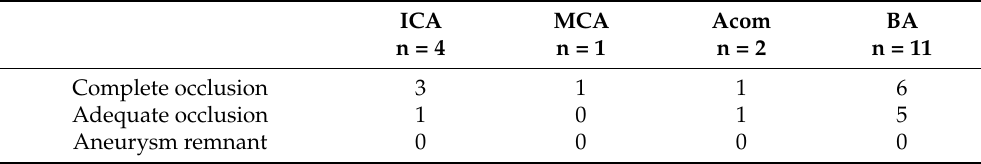
Table 4. Aneurysm occlusion degree in relation to its position at 3-year follow-up.